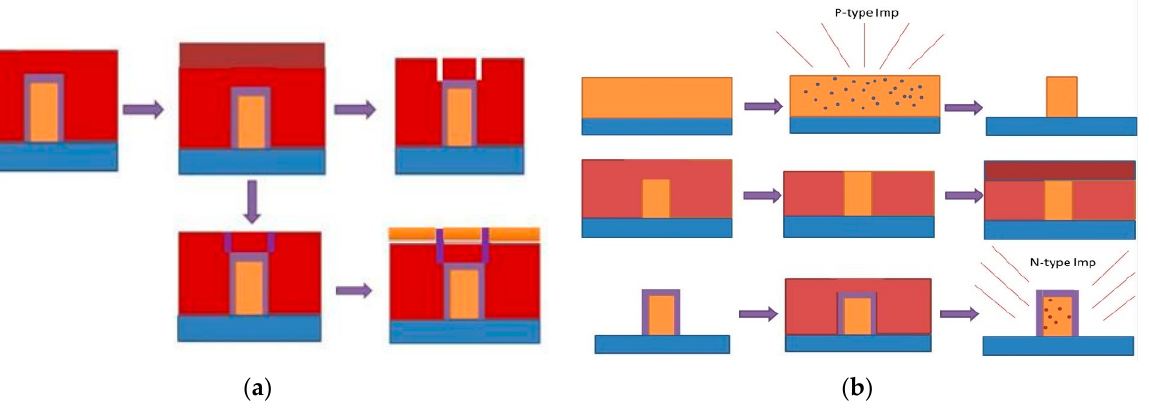
Figure 3. Device construction procedures: ( a ) procedure I ( b ) procedure II.